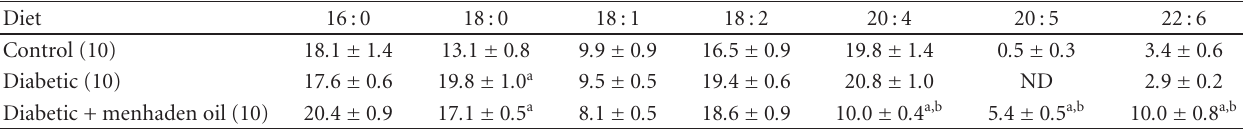
Table 2: E ff ect of partial menhaden oil substitution on fatty acid % composition of serum measured by gas chromatography. Diet